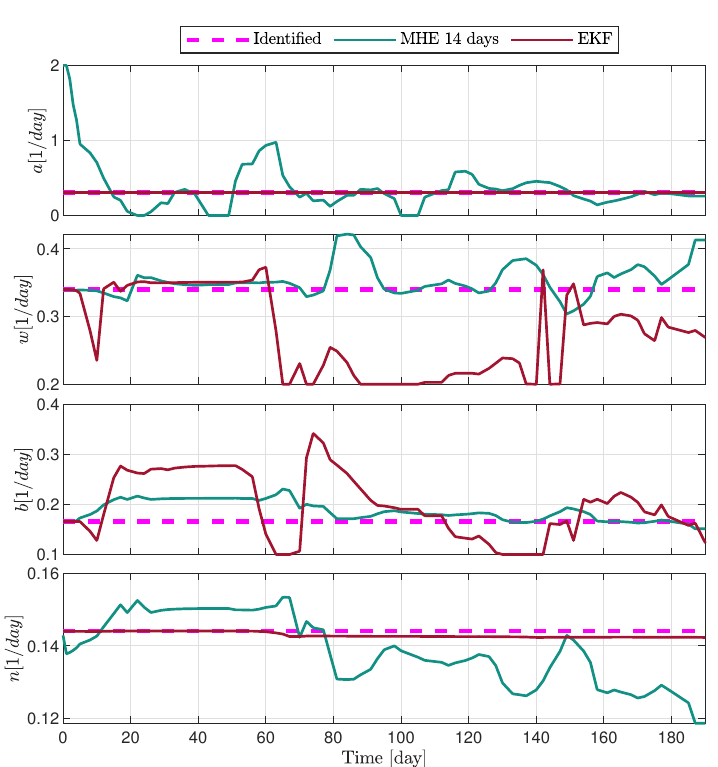
Figure 10. Estimated parameters of PLD6